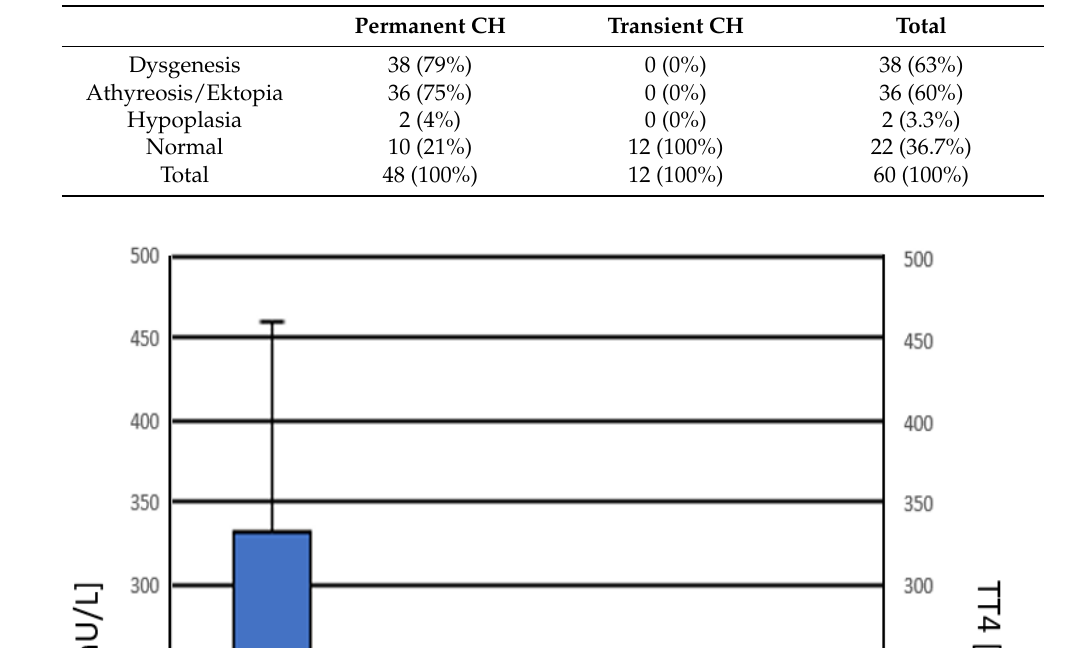
Table 5. Diagnostic findings of thyroid sonography. [n (%)].